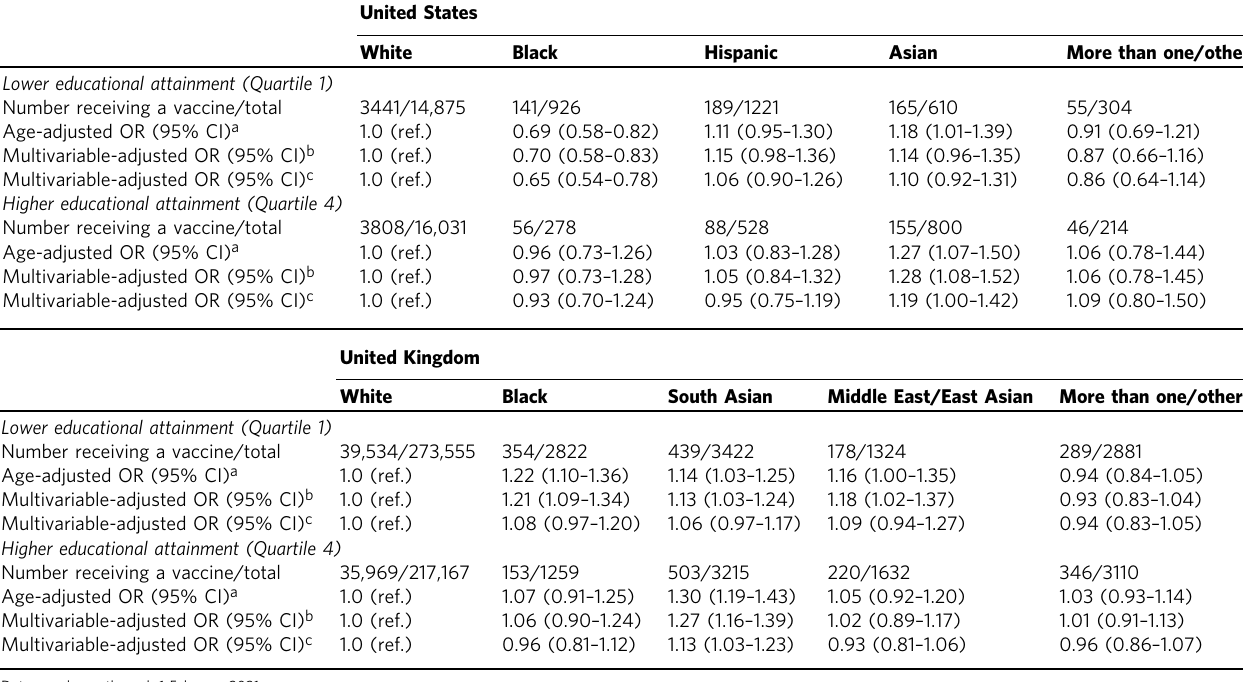
Table 6 Vaccine uptake by race and ethnicity according to country of enrollment by educational